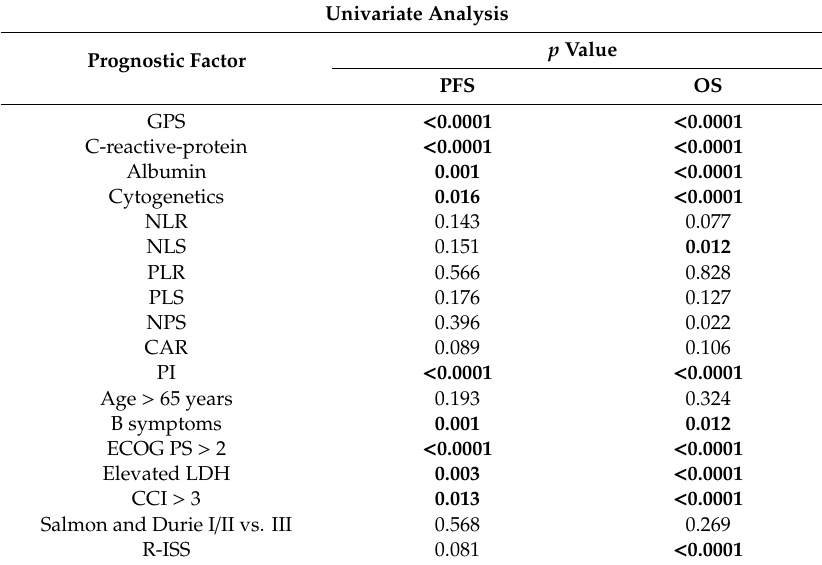
Table 5. Progression-free and overall survival in univariate analysis (log-rank test).